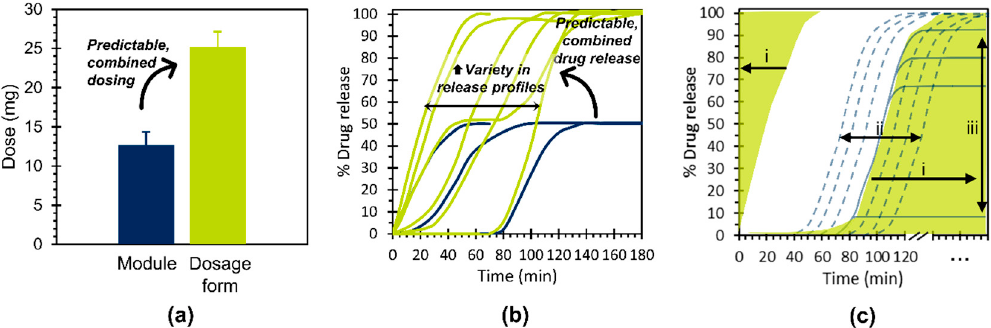
Figure 10. Summary of key demonstrated outcomes: ( a , b ); future potential of the concept to deliver increased product variety predictably using reconfigurable modularization: ( c ).